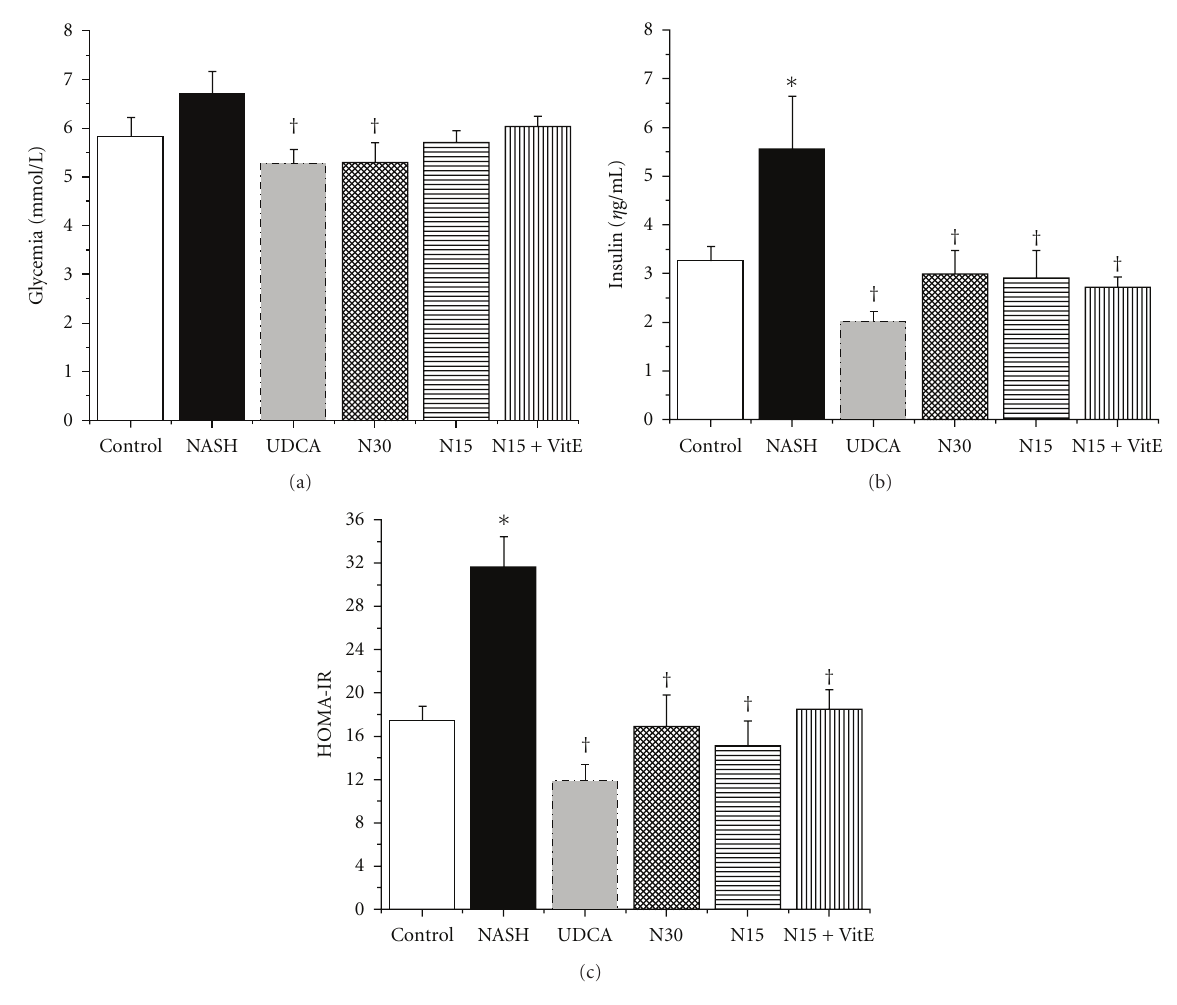
Figure 1: E ff ect of treatments on glycemic homeostasis. Table 2: E ff ect of treatments on biochemical and lipid